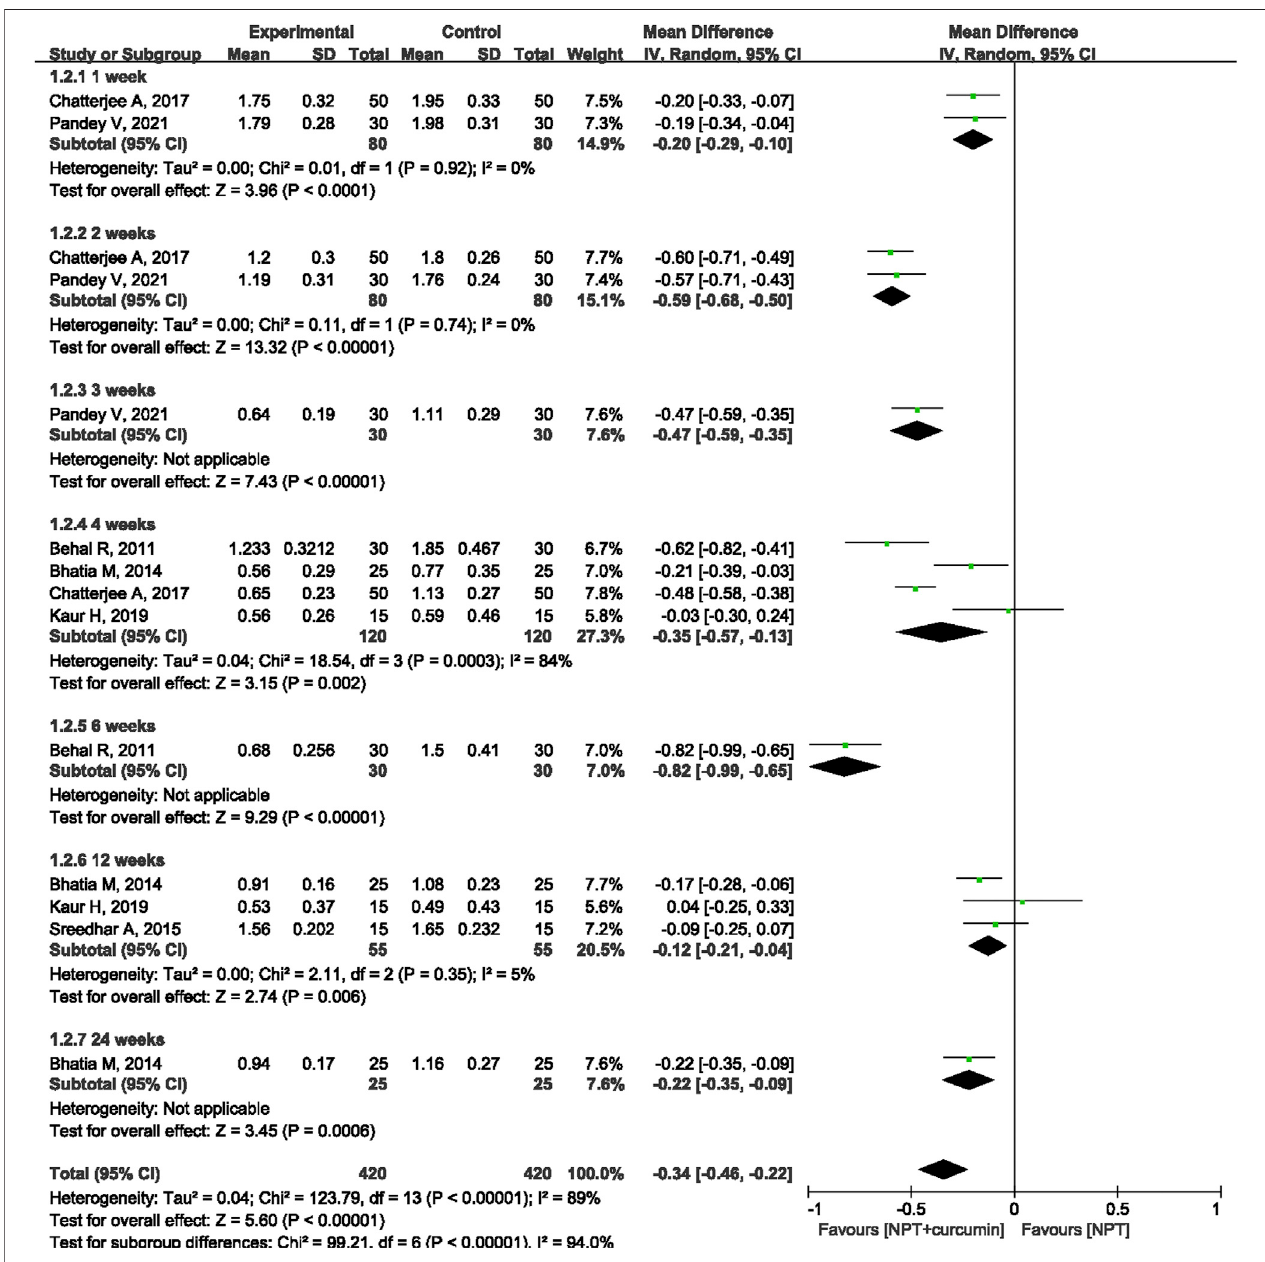
FIGURE 5 | Forest plot of the effects of curcumin + NPT versus NPT on SBI.